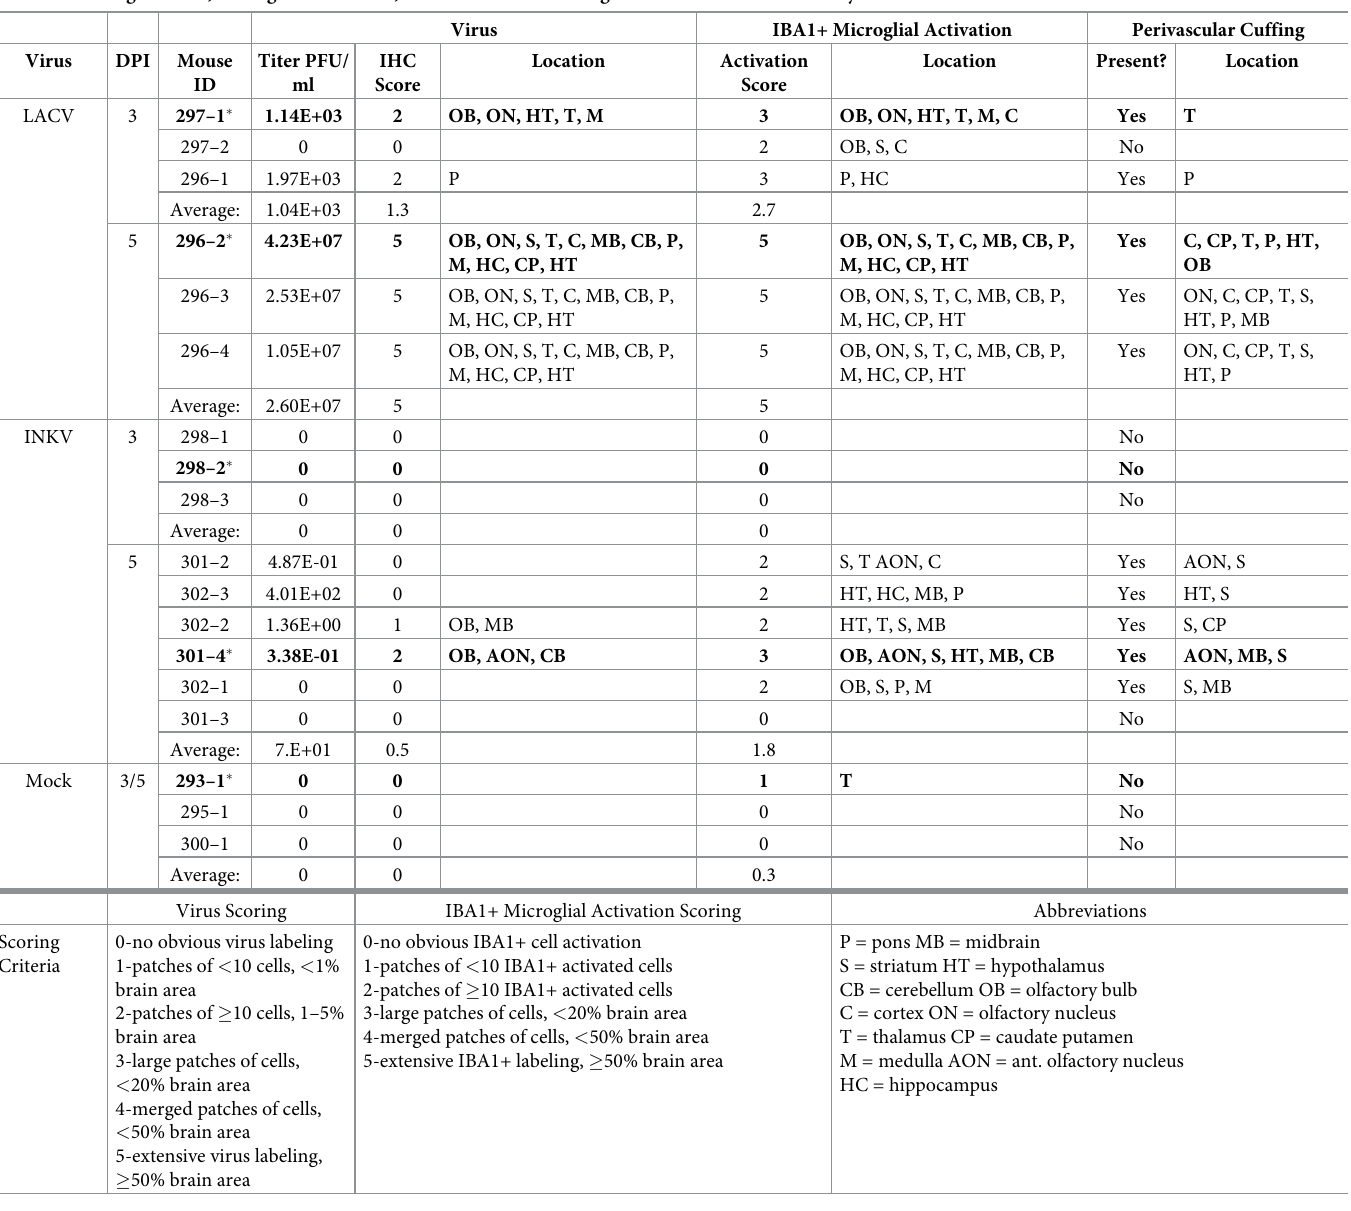
Table 1. Scoring of Virus, Microglial Activation, and Perivascular Cuffing from Immunohistochemistry. Virus IBA1+ Microglial